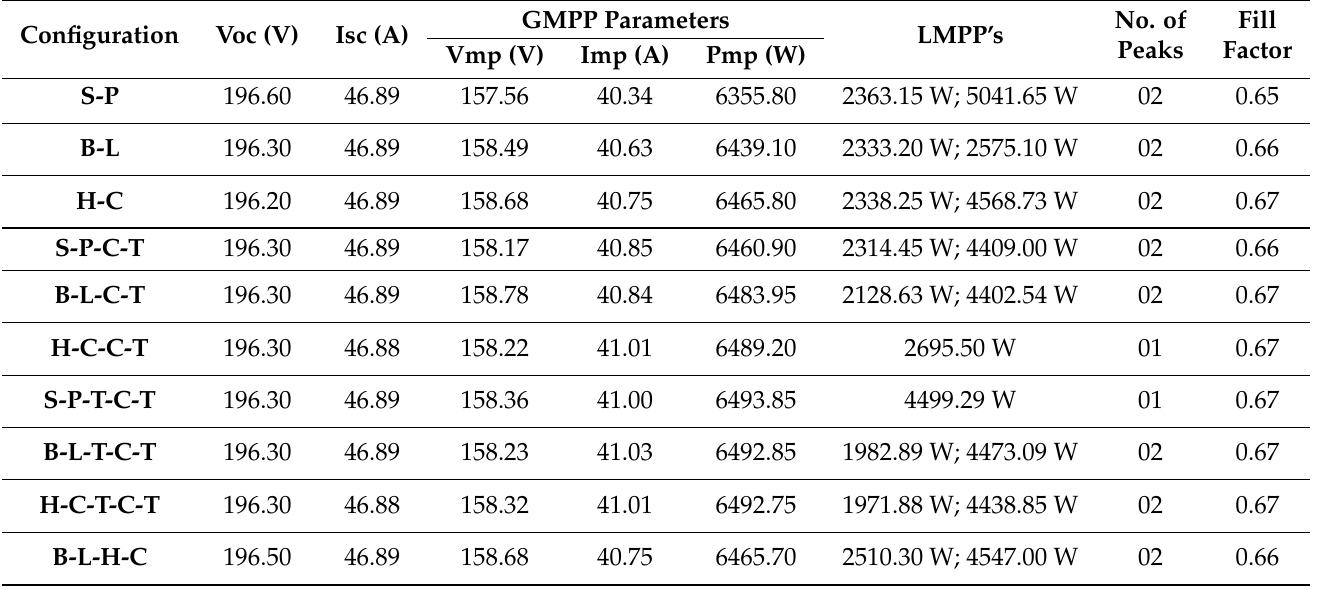
Table 3. Parameter variations of conventional and hybrid configurations under uneven-column pattern.